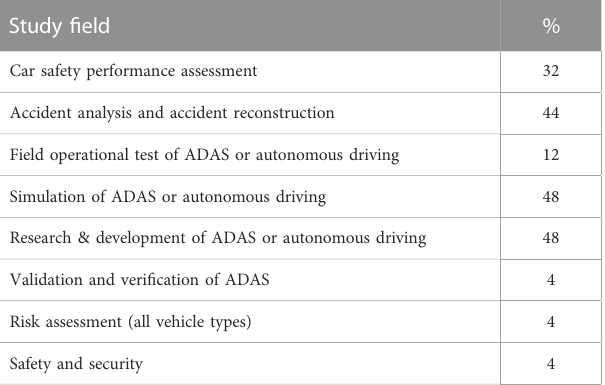
TABLE 2 Coverage of the knowledge of the 25 surveyed experts in different study fi elds. Study fi eld